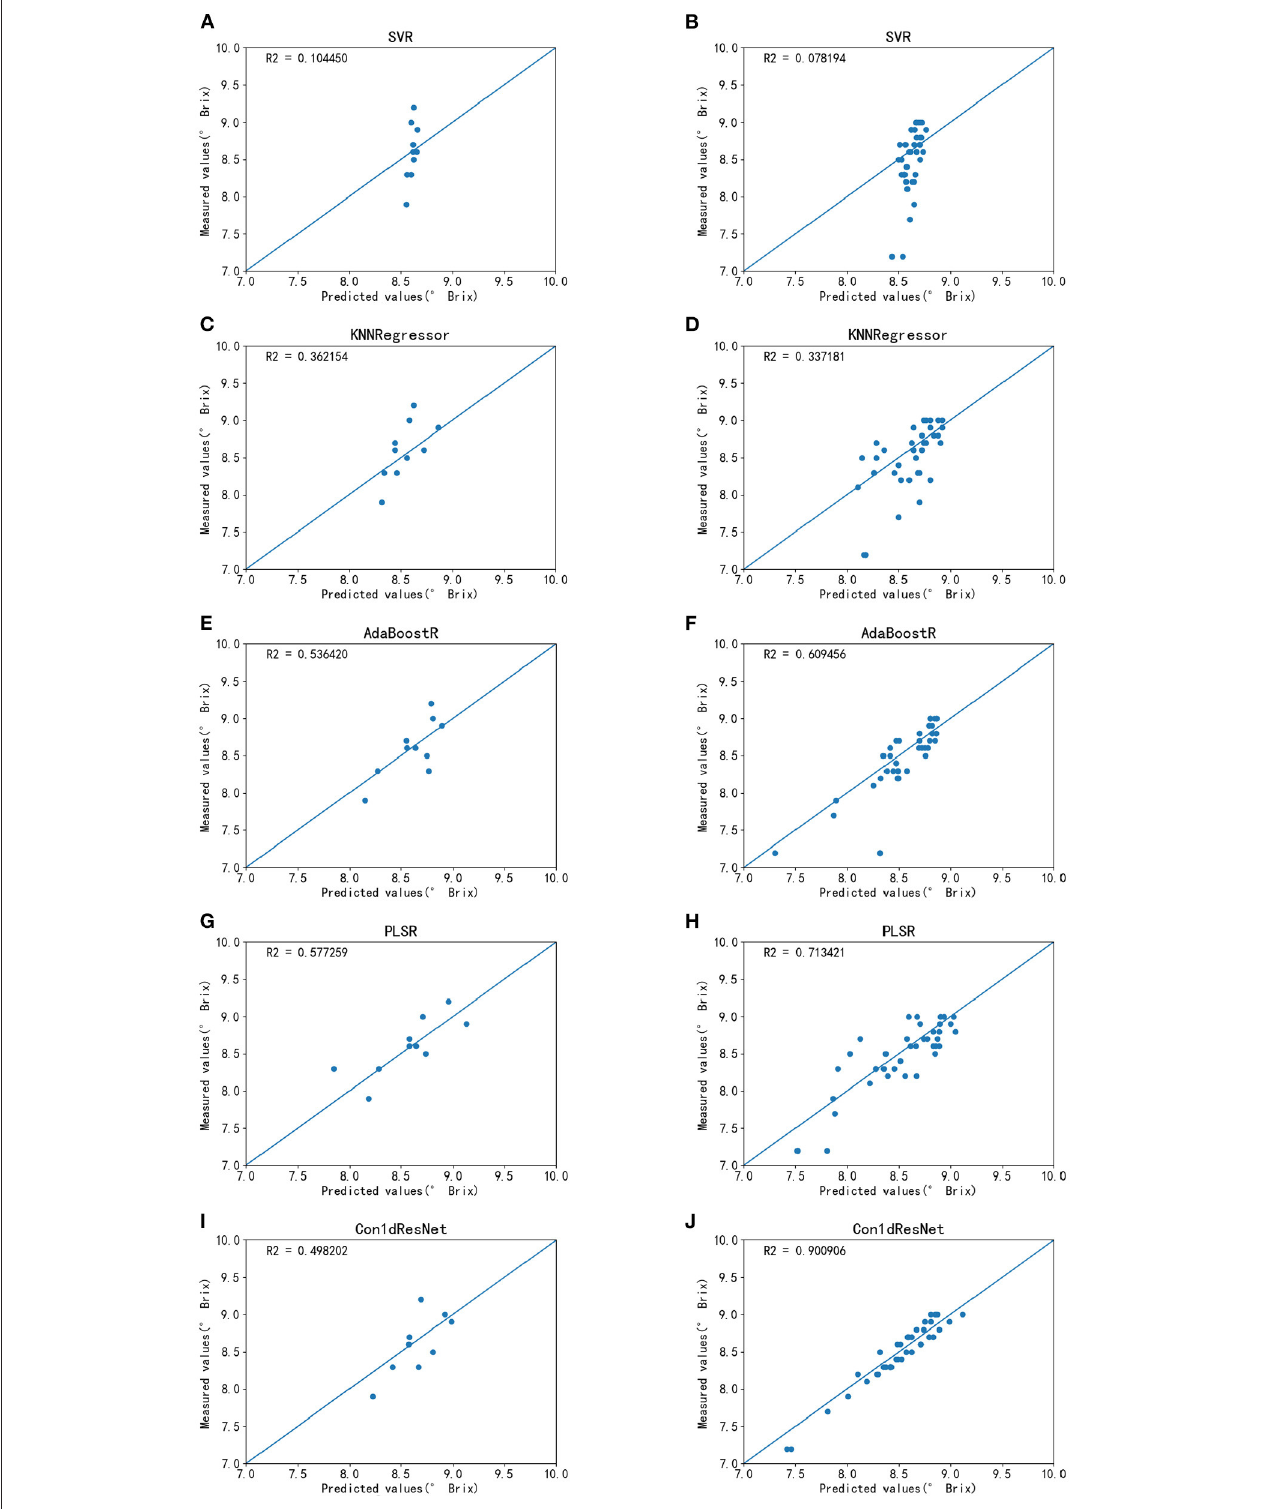
FIGURE 6 | SSC estimation results for each model. (A) SVR estimation results on small sample data. (B) SVR estimation results on large sample data. (C) KNNR estimation results on small sample data. (D) KNNR estimation results on large sample data. (E) AdaBoostR estimation results on small sample data. (F) AdaBoostR estimation results on large sample data. (G) PLSR estimation results on small sample data. (H) PLSR estimation results on large sample data. (I) Con1dResNet estimation results on small sample data. (J) Con1dResNet estimation results on large sample data.